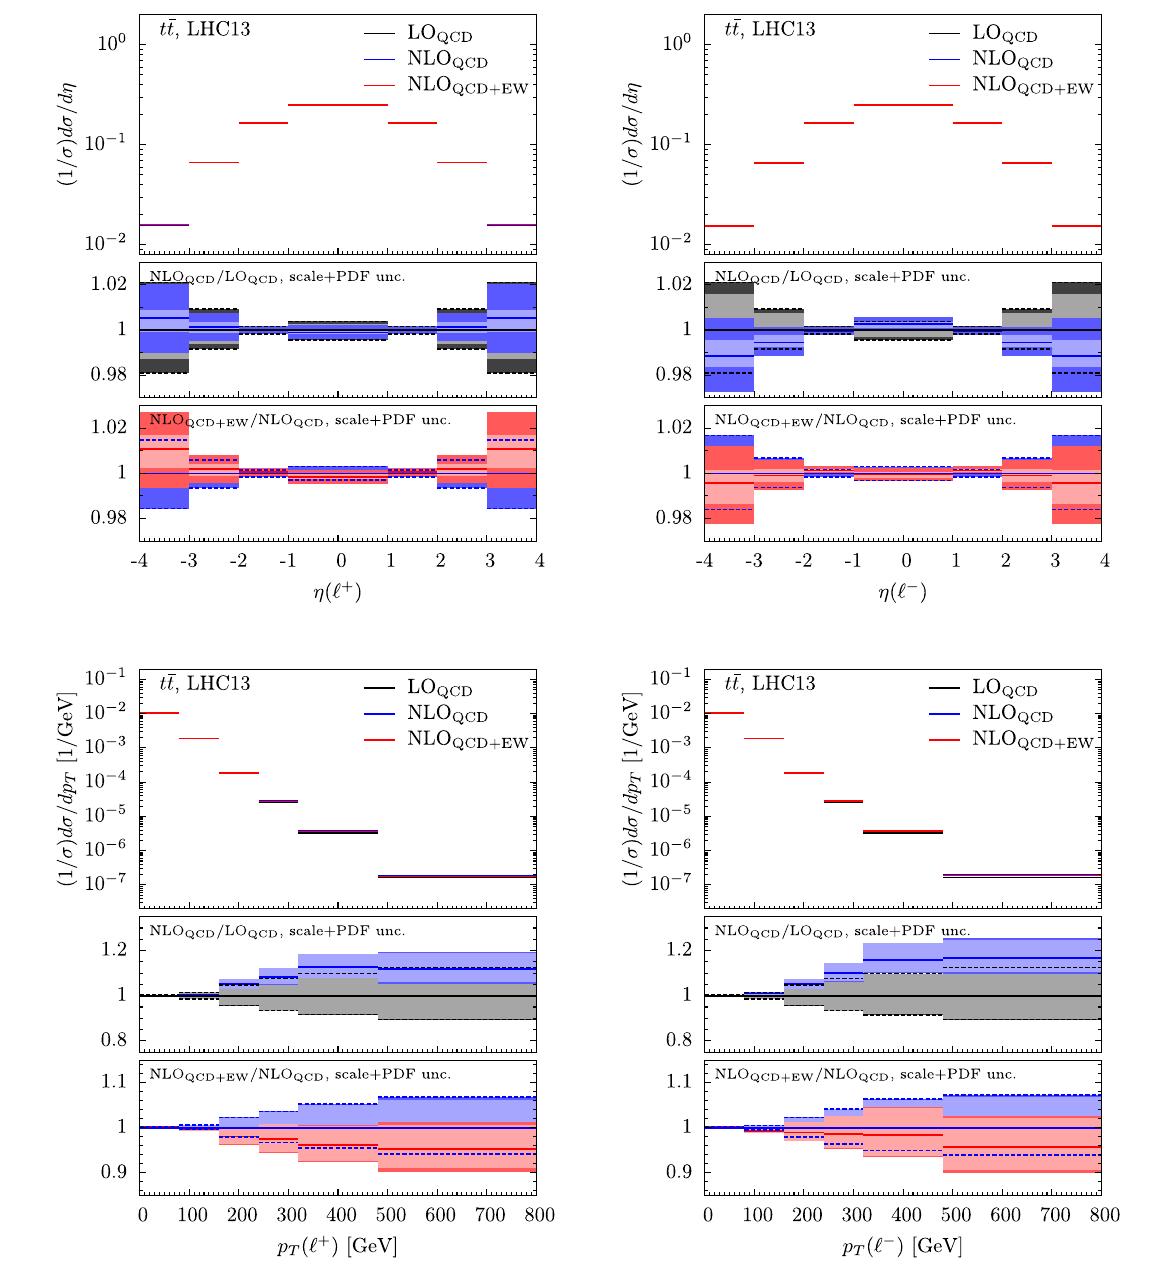
Fig. 3 Pseudorapidity (upper) and transverse momentum (lower) lepton distributions